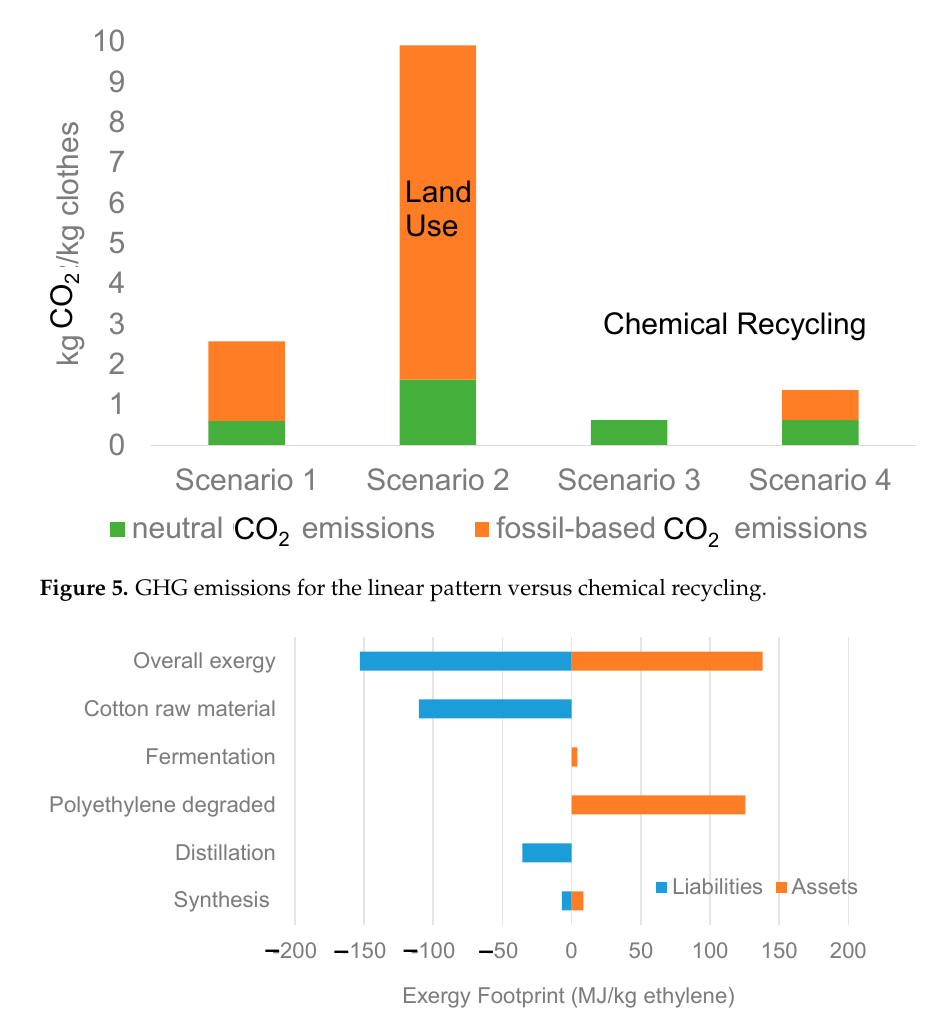
Figure 6. Exergy Footprint for the cotton fermentation cycle to polyethylene.